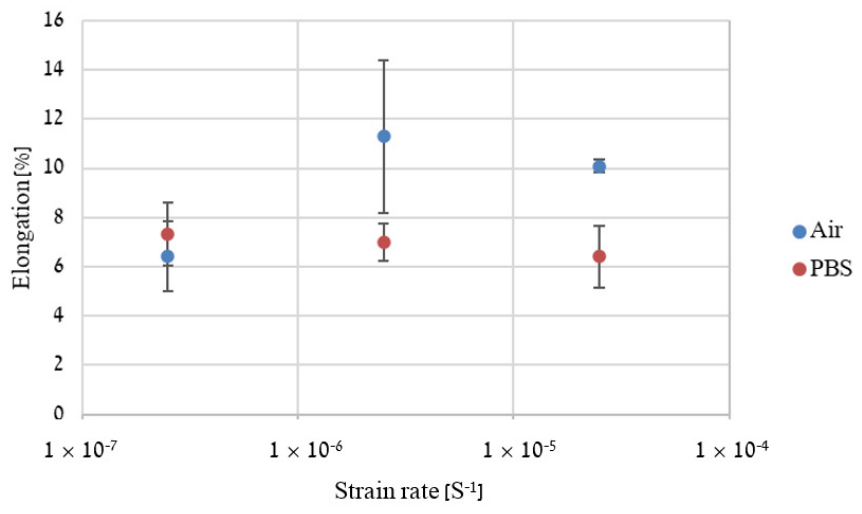
Figure 7. Elongation Vs. strain rate of Zn-2%Fe-0.6%Ca alloy in air and PBS solution.